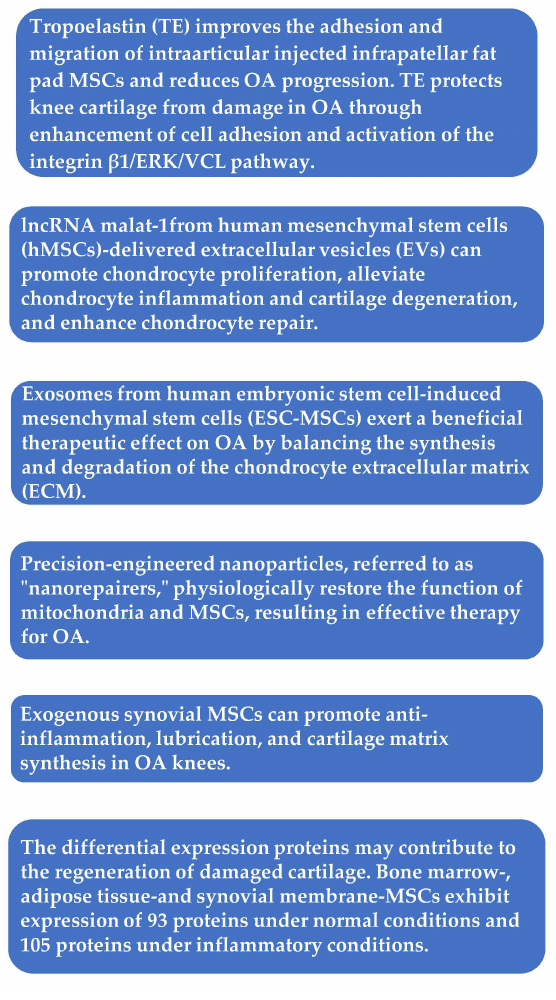
Figure 2. Mesenchymal stem cells (MSCs): cellular effect of their action. OA = osteoarthritis; ERK = extracellular signal-regulated protein kinase; VCL = vinculin; lncRNA = long non-coding